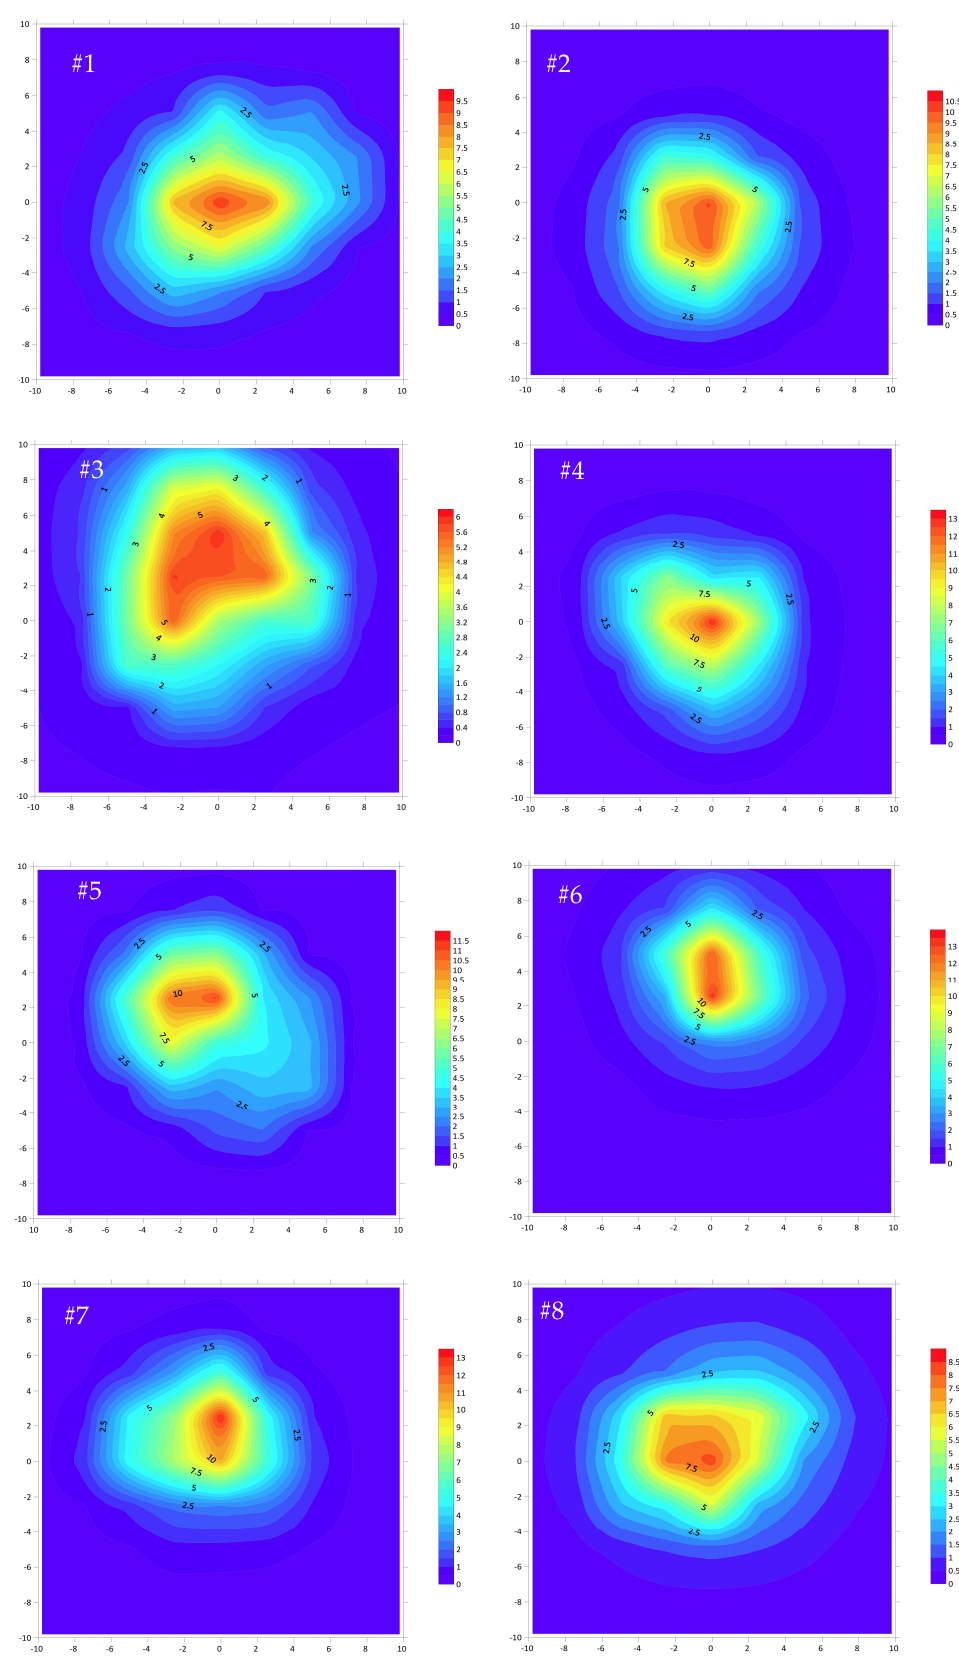
Figure 13. Irradiance [W/cm 2 ] of the case 13 of Table 3; the numbers #1 ÷ #8 represent the lamps, according to Figure 2; the coordinates are expressed in cm from the center of the workbench.